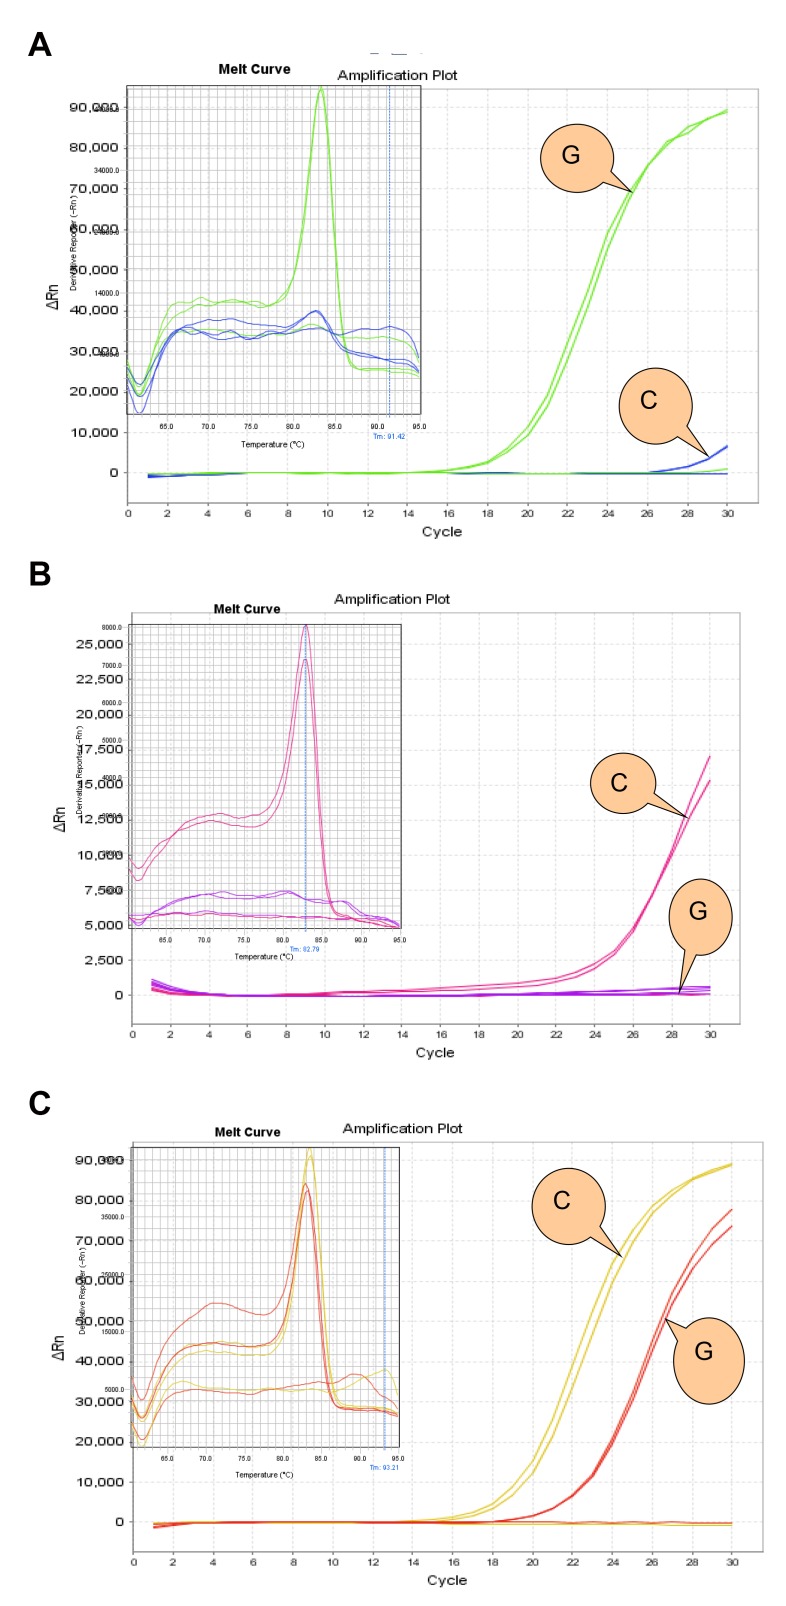
GG, CC and GC genotypes in the samples.Fig. 2 A, B and C show GG, CC and GC genotype respectively as shown by the results obtained by RT-PCR.